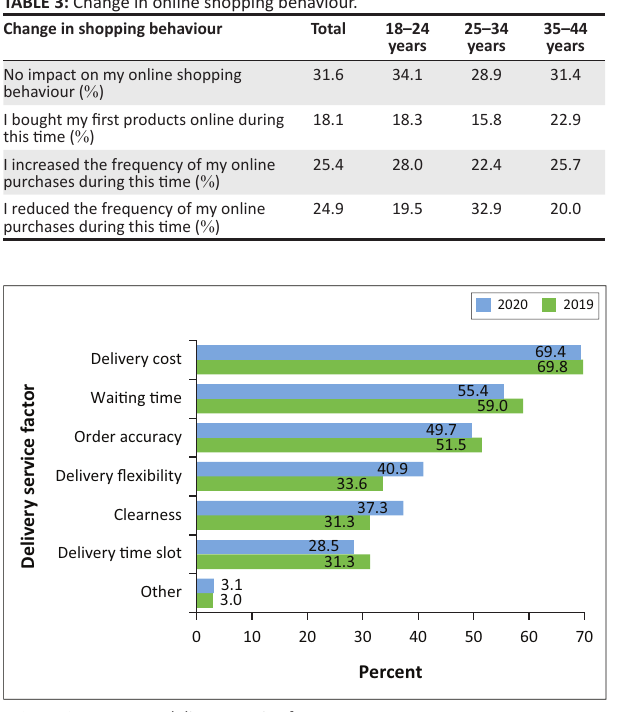
from 2019 preferred to receive their deliveries between